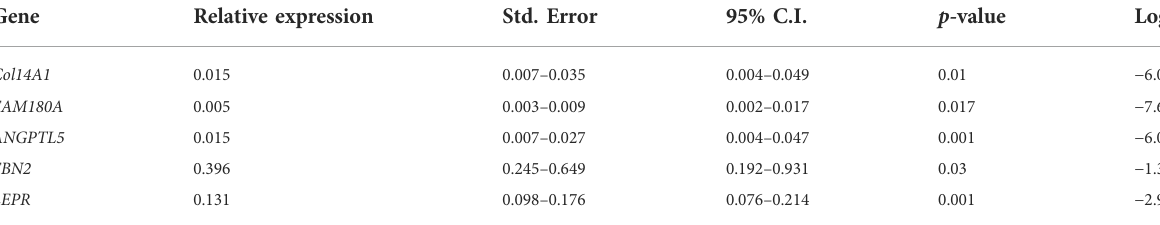
TABLE 3 Relative gene expression and LogFC between FHS-affected.and control groups and results of differential expression analysis using REST. Gene Relative expression